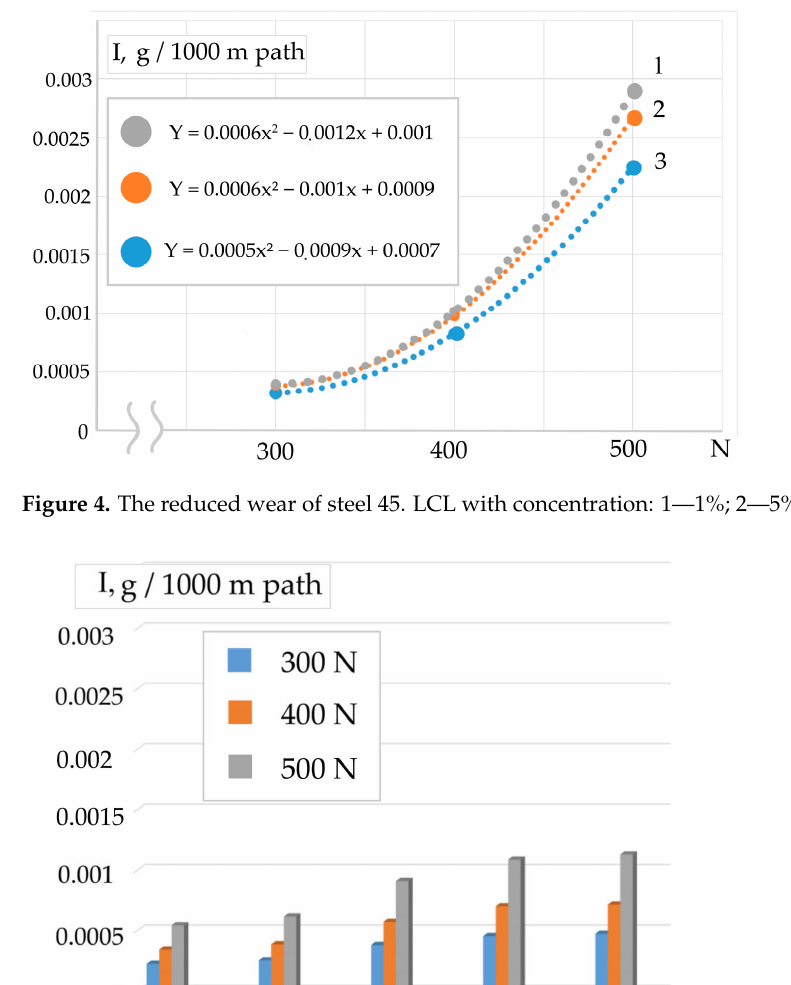
Figure 3. The reduced wear of steel 45. Contact with liquids: 1 — Shell HF-E 46 (synthetic); 2 — Shell